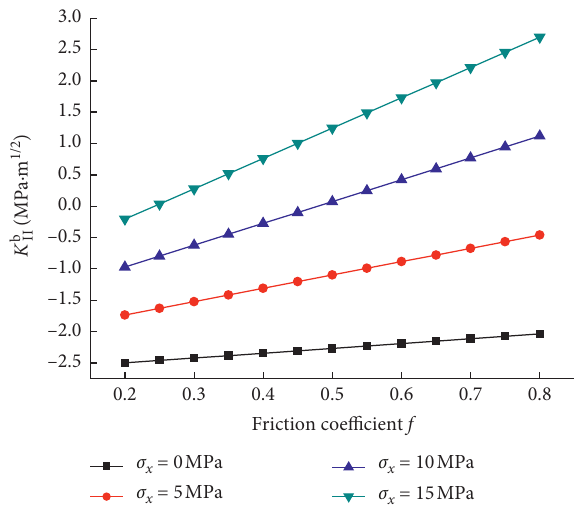
Figure 10: Relationship between friction coefficient and mode II stress intensity factor at different lateral pressure of closed cracks ( P w � 0 MPa).